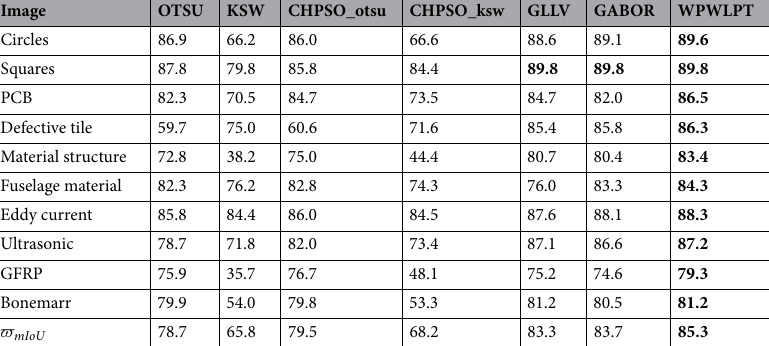
Table 8. mIoUs (%) of the different thresholding methods. The best results are highlighted in